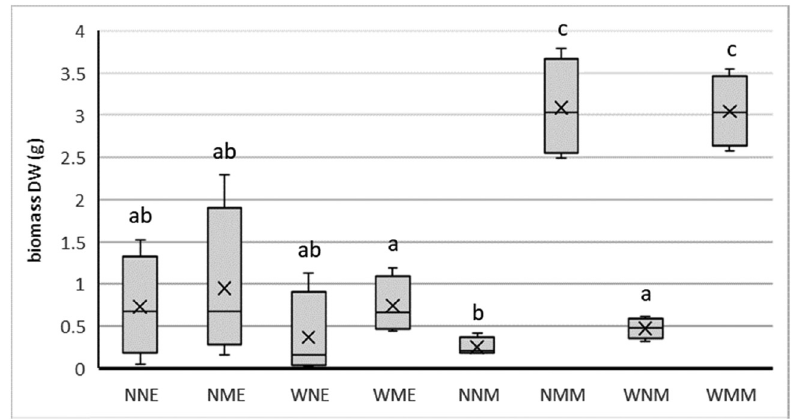
Figure 2: Box plot of the harvested biomass ( dry weight ) per treatment. Treatment code indicates for fi rst letter for worm ( W ) or no worm ( N ) added; for the second letter for manure ( M ) or no manure ( N ) added; for the third letter for Earth control ( E ) and Mars soil simulant ( M ) . Di ff erent letters indicate signi fi cant di ff erences at p =